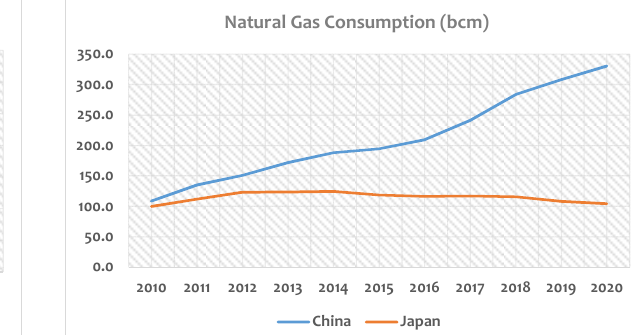
Figure 6. Based on data from [4].